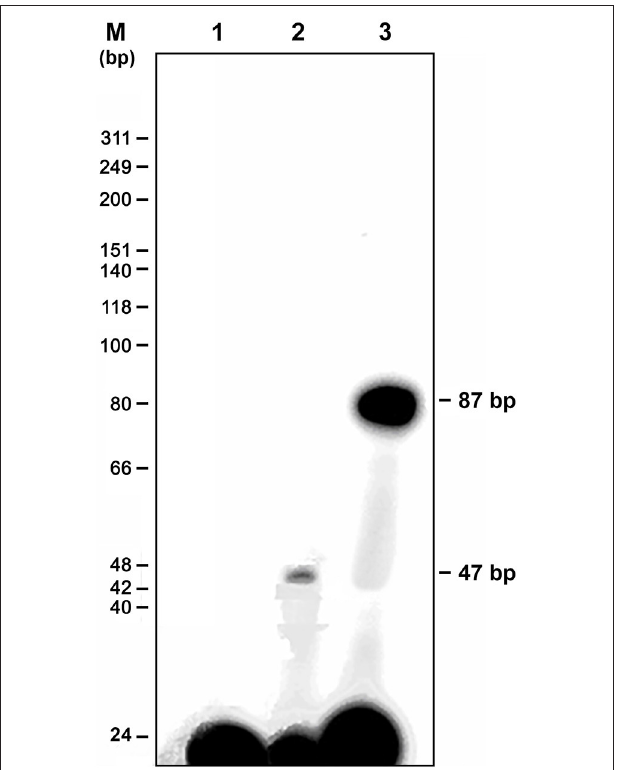
FIGURE 2 | Mapping of the transcription start site (TSS) by primer extension analysis. A primer extension kit (Promega) was used in accordance with the instructions from the manufacturer; mRNA was prepared from a 4-day-old female fat body. A 22-bp synthetic oligonucleotide complementary to nt 18–39 of Vg2 was synthesized, end-labeled with 32 P ATP, and used as a primer to produce a single product that was 47 bp in length (lane 2). The DNA marker and a negative control without mRNA are shown in lanes M and 1, respectively. The 87 bp product is the positive DNA control supplied with the kit (lane